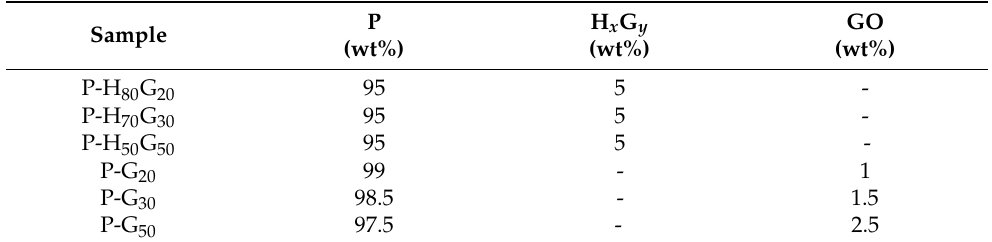
Table 1. Acronyms and composition of nano-hybrid/pectin composites (P-H x G y ) and grapefruit seed oil/pectin composites (P-G y